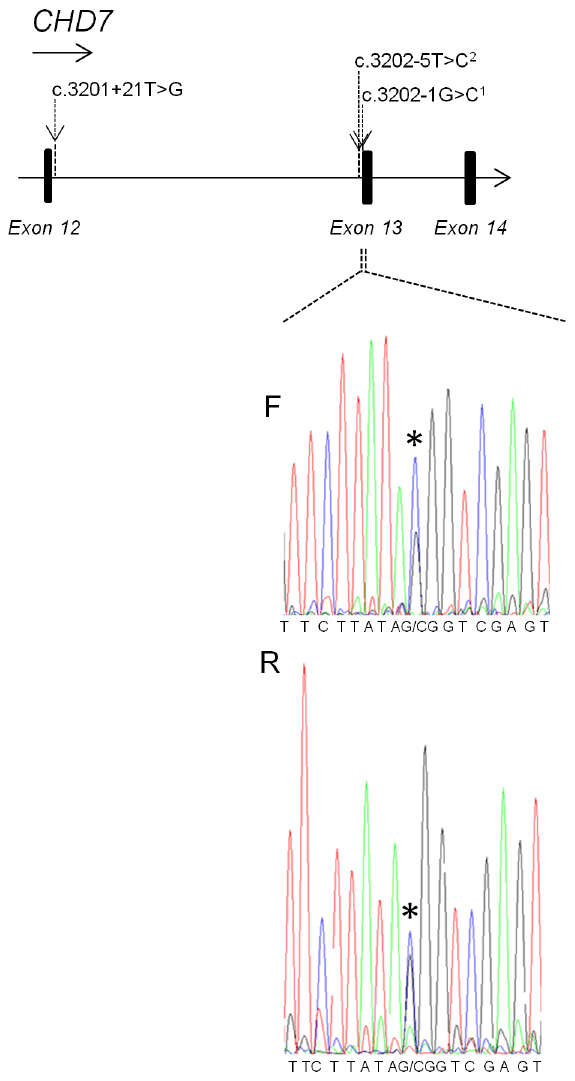
Figure 4. Results from DNA sequencing of the CHD7 gene. Upper part showing single base mutations in intron 12 of the CHD7 gene reported in the CHD7 database (www.chd7.org) together with the pathogenic c.3202-1 G . C mutation identified in patient V15 (1). The c.3202-5T . C mutation (2) has been reported in four patients in the CHD7 database and was found in patient V7 in our study. We consider the mutation to be of unclear clinical significance since experimental evidence does not indicate that it affects splicing. Lower part showing the pathogenic mutation c.3202-1G . C (*) detected in patient V15 in forward (F) and reverse (R)